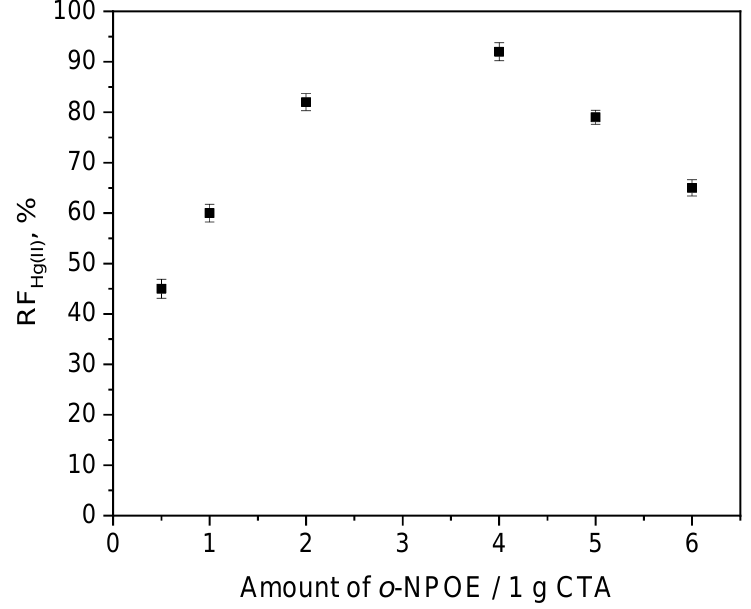
Figure 5. The effect of o -NPOE plasticizer on the recovery factor of Hg(II) transport through PIM containing KP. Source phase: 1.0 × 10 − 6 M Hg(II), 0.1 M HCl; membrane: 19 wt.% of CTA, 4 wt.% of KP; receiving phase: 0.1 M NaCl.